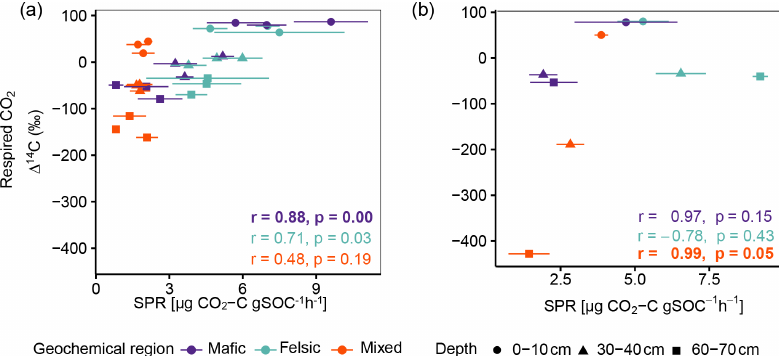
Figure A4. Pearson correlation between (cid:49) 14 C of respired CO 2 and SPR for (a) for non-valley positions and (b) for valley positions. Data displayed are averages plus the standard error of three field replicates (non-valleys n = 85 and valley position n = 27). p values in bold indicate significant results at p <